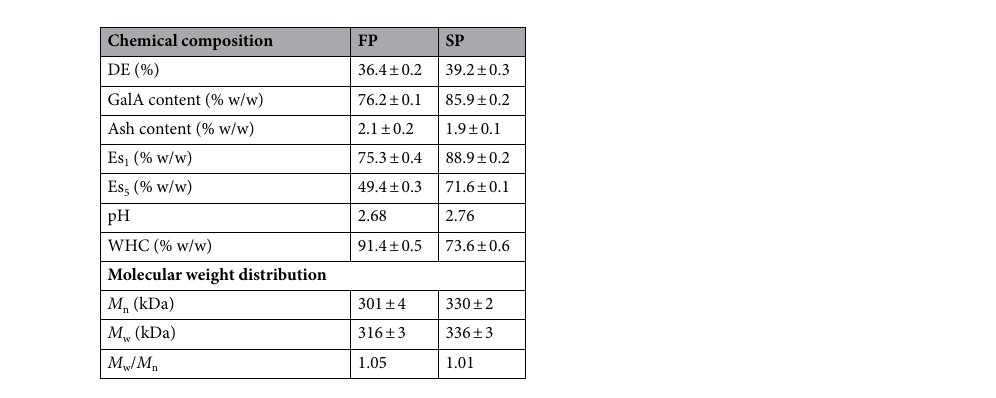
Table 3. Chemical and physicochemical properties of FP and SP extracted under optimal extraction conditions.